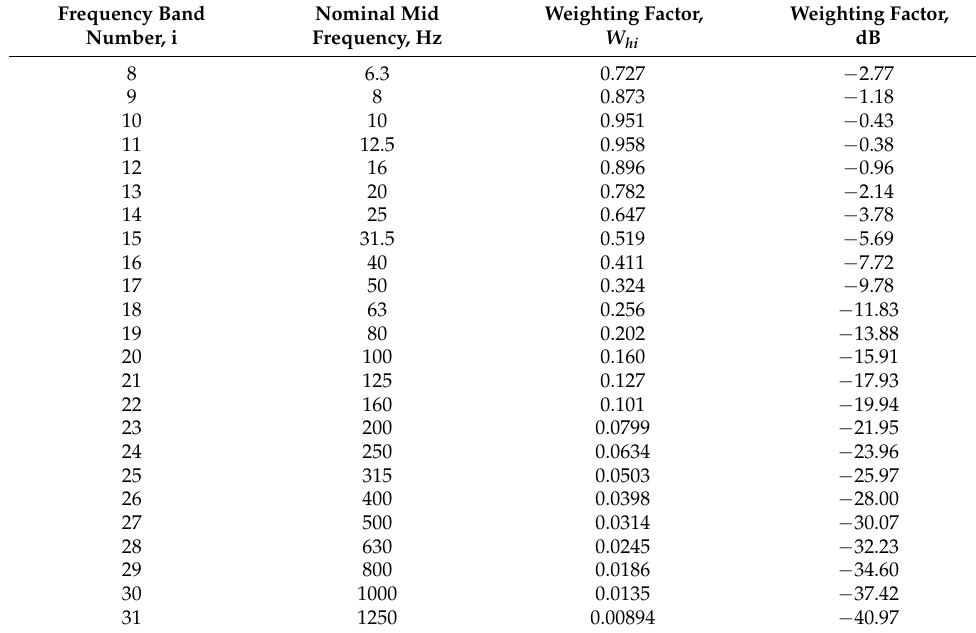
Table 4. Frequency weighting factors for hand-arm